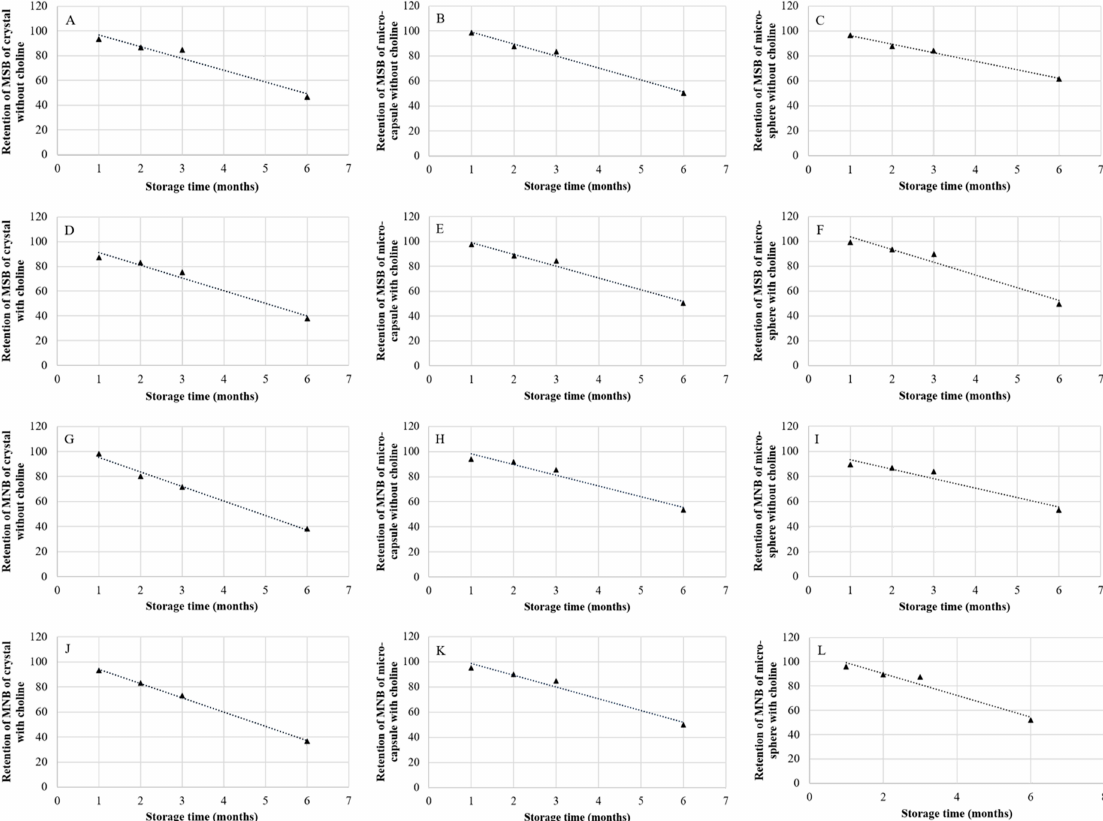
Figure 2. Prediction equations for vitamin K 3 retention (%) in vitamin trace mineral (VTM) premixes during storage. ( A ) Retention of MSB of crystal without choline (y = − 9.5393x + 106.29, R 2 = 0.951); ( B ) Retention of MSB of micro-capsule without choline (y = − 9.5707x + 108.66, R 2 = 0.988); ( C ) Retention of MSB of micro-sphere without choline (y = − 6.8729x + 103.11, R 2 = 0.991); ( D ) Retention of MSB of crystal with choline (y = − 10.227x + 101.33, R 2 = 0.970); ( E ) Retention of MSB of micro-capsule with choline (y = − 9.4579x + 108.52, R 2 = 0.983); ( F ) Retention of MSB of micro-sphere with choline (y = − 10.225x + 113.7, R 2 = 0.954); ( G ) Retention of MNB of crystal at without choline (y = − 11.606x + 106.85, R 2 = 0.989); ( H ) Retention of MNB of micro-capsule without choline (y = − 8.5214x + 106.62, R 2 = 0.958); ( I ) Retention of MNB of micro-sphere without choline (y = − 7.5507x + 100.93, R 2 = 0.938); ( J ) Retention of MNB of crystal with choline (y = − 11.378x + 105.59, R 2 = 0.998); ( K ) Retention of MNB of micro-capsule with choline (y = − 9.3086x + 107.79, R 2 = 0.968); ( L ) Retention of MNB of micro-sphere with choline (y = − 8.9407x + 108.06, R 2 = 0.952). MSB, menadione sodium bisulfite; MNB, menadione nicotinamide